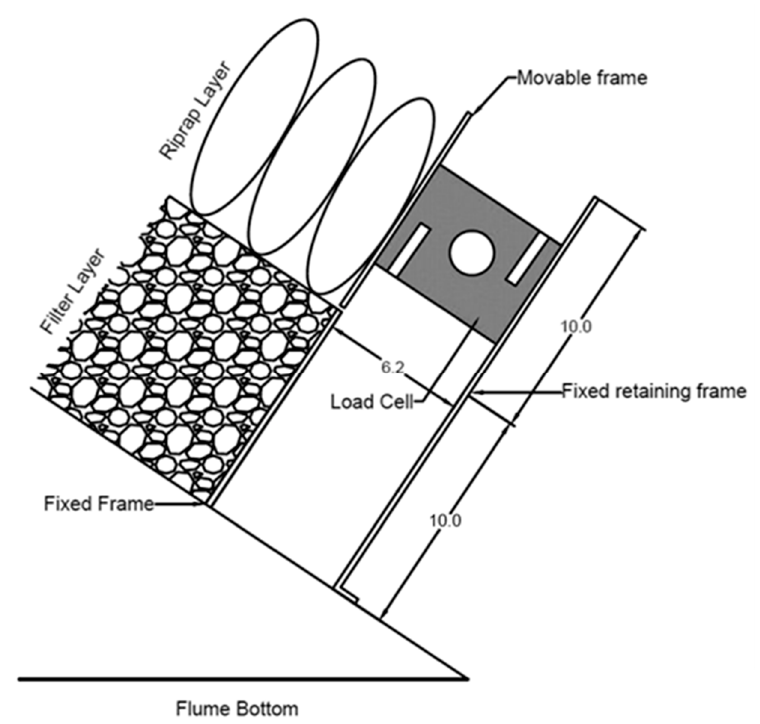
Figure 3. Load cell positioning against the riprap layer between two metallic frames with dimen- sions in